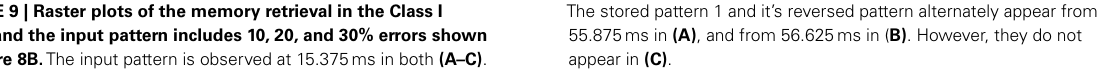
The stored pattern 1 and it’s reversed pattern alternately appear from 55.875ms in (A) , and from 56.625ms in ( B) . However, they do not appear in (C)